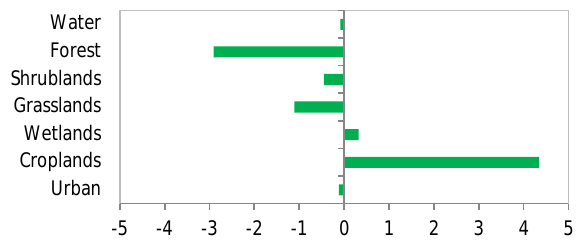
Figure 2. Net land cover changes between 2001 and 2008.